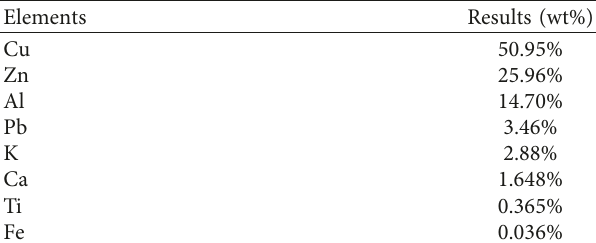
Table 5: Brass electrode in titanium parent